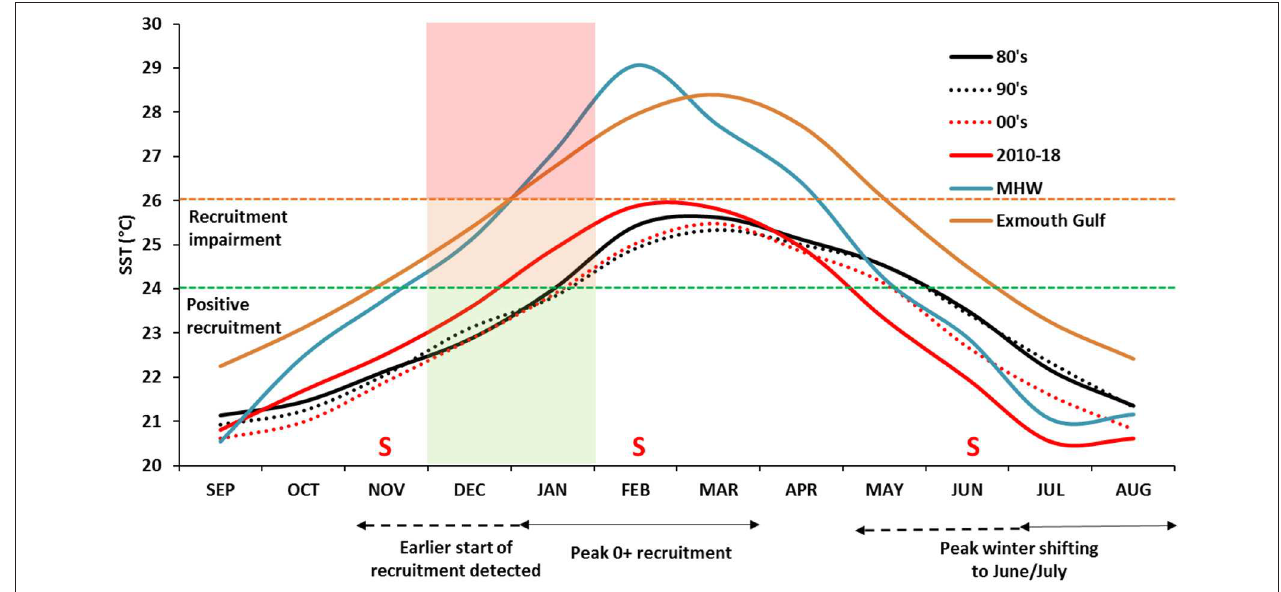
FIGURE 10 | Decadal trends in mean monthly SST between the 1980’s, 1990’s, 2000s in Shark Bay in comparison to the months pre and post 2011 MHW (September 2010-August 2011) and mean monthly SSTs in Exmouth Gulf (1981–2009). Overlain on the plot are the temperature thresholds for positive recruitment (24 ◦ C) and recruitment impairment (26 ◦ C) during December and January. Fishery-independent survey months indicated by